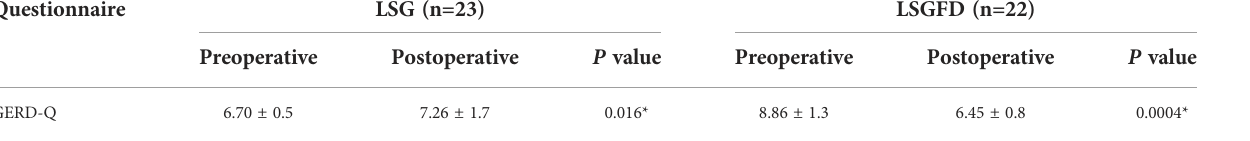
TABLE 4 (A) Changes in questionnaire scores after LSG and LSGFD.